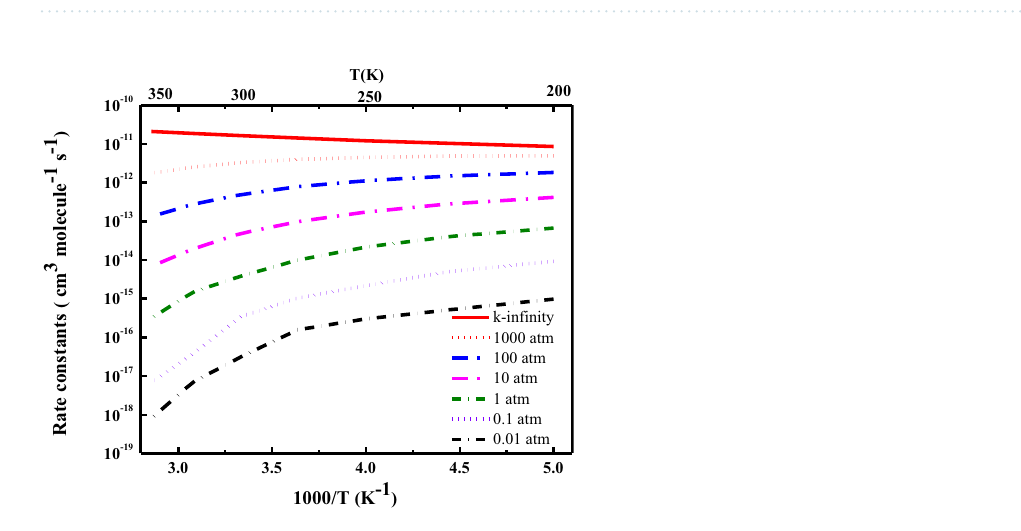
Figure 4. “Trial” TSs of CH 2 NH + H 2 O reaction at several R N−O distances along the reaction pathway forming CH